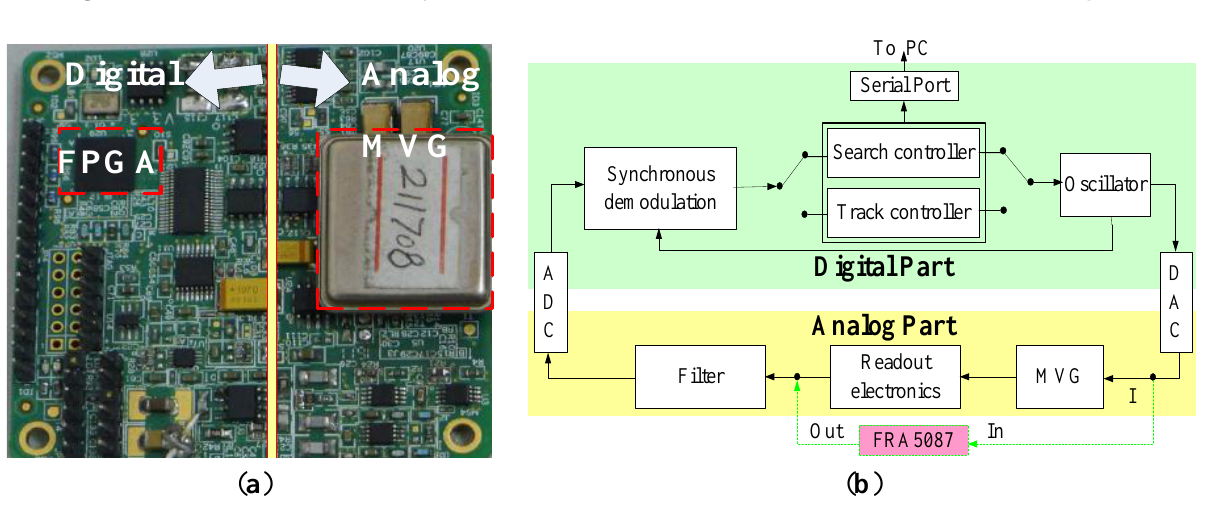
Figure 13. The implemented system for experiments. ( a ) The PCB. ( b ) The block